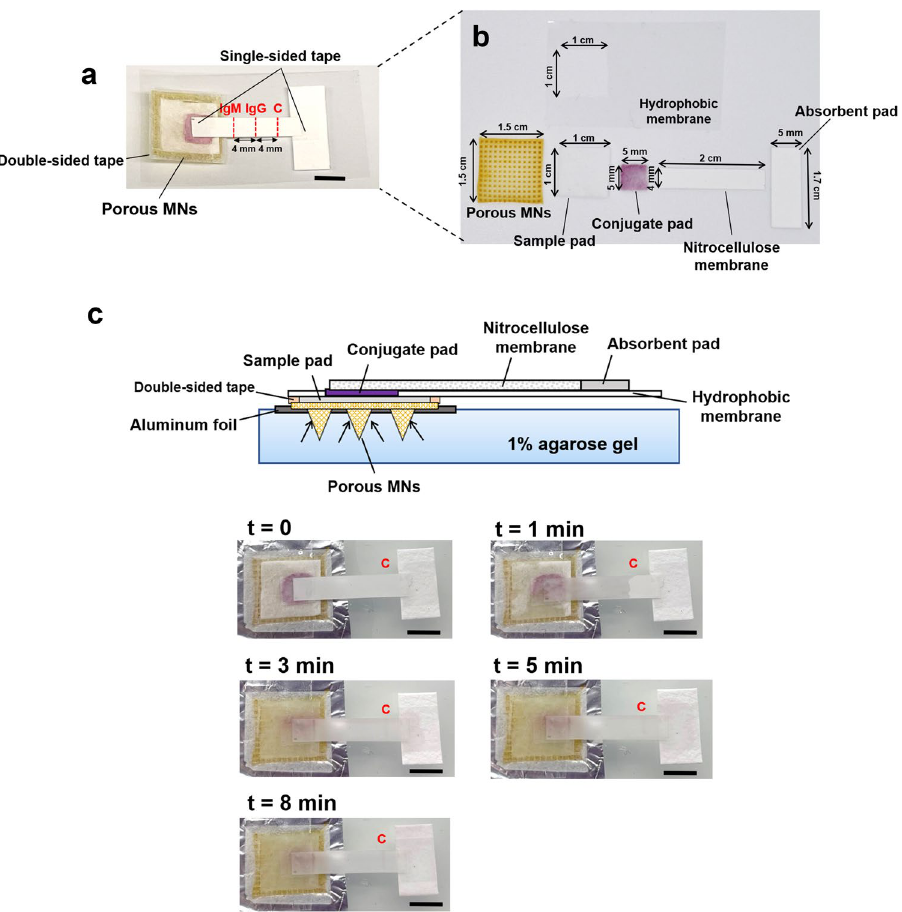
Figure 5. Assembly of the PMNIA as the anti-SARS-CoV-2 antibody detection patch, its fluid extraction capability, and complete flow testing time. ( a ) Image of the assembled detection patch integrated with porous MNs and paper-based immunoassay biosensor. Scale bar, 5 mm. ( b ) Components of the PMNIA assembly. ( c ) Illustration of the PMNIA applied on the skin model and sequential still frame images demonstrating sample fluid extraction by porous MNs and transport through the entire immunoassay biosensor leading to the development of reddish-purple color on the control line. Application time is indicated in the upper left corners. “c” in red represents control line. Scale bar, 5